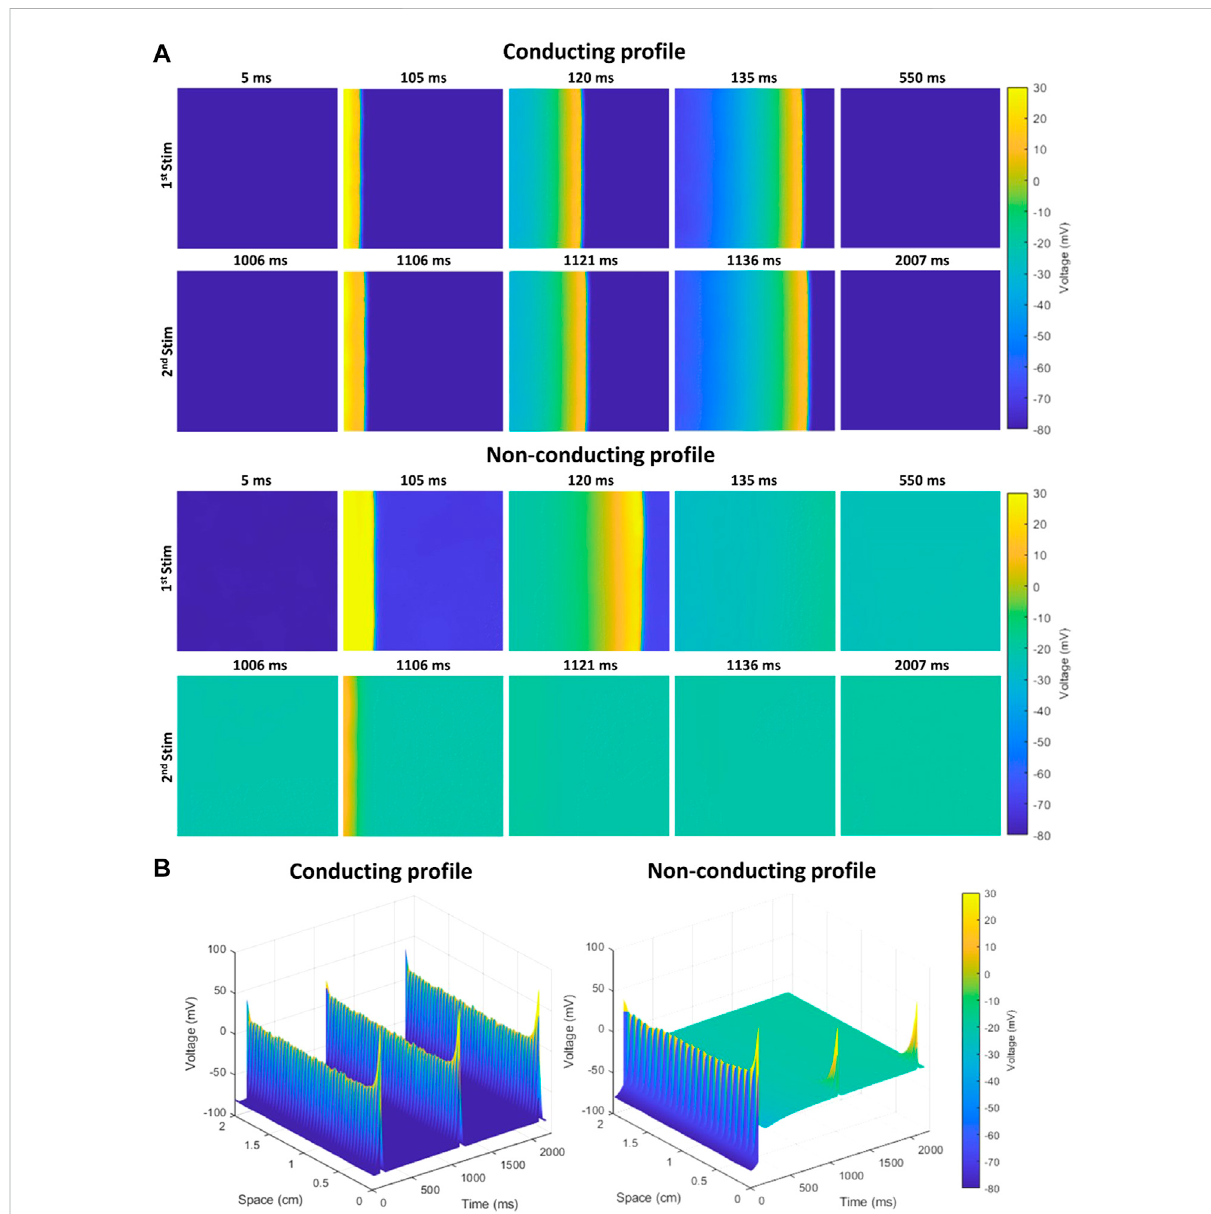
FIGURE 1 Example of conducting and non-conducting pro fi les both with 10% of fi brosis, in the absence of the effect of any antiarrhythmic drug. (A) Propagation of two stimuli in each pro fi le across the simulated tissue (2 cm × 2 cm) from left to right, with no- fl ux boundary conditions. While the second impulse propagates in the fi rst pro fi le, it does not in the second pro fi le as the simulated tissue is failing to repolarize to initial membrane potential. (B) Time-space plot along the propagation direction in both pro fi les, showing effective propagation in the fi rst pro fi le and the blockade in the second pro fi